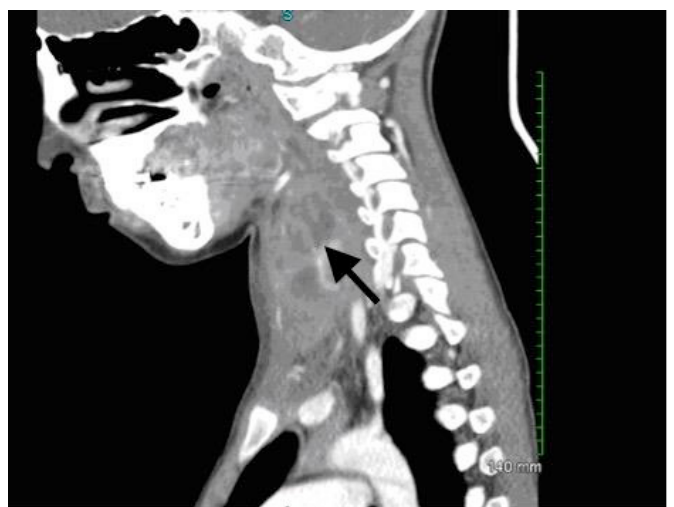
Image 2 . Saggital computed tomography of the neck demonstrating multiloculated heterogeneous fluid (arrow) in the left thyroid